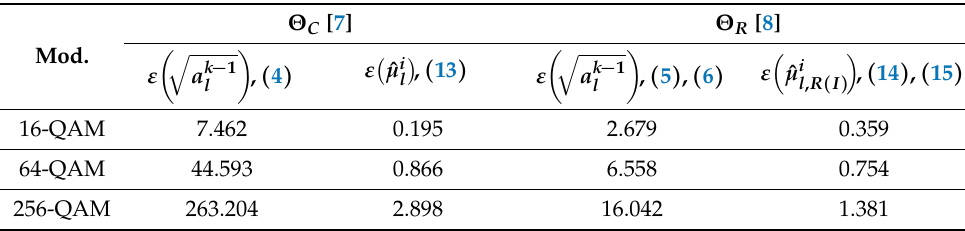
Table 1. Comparisons of ε ( ˆ µ l ) for the conventional and new detections.